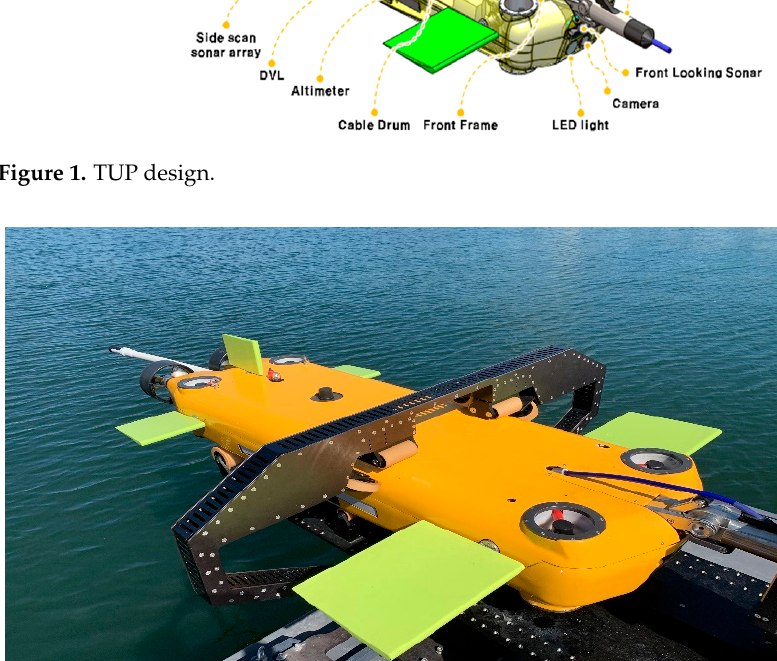
Figure 2. TUP Figure 2. TUP implementation.